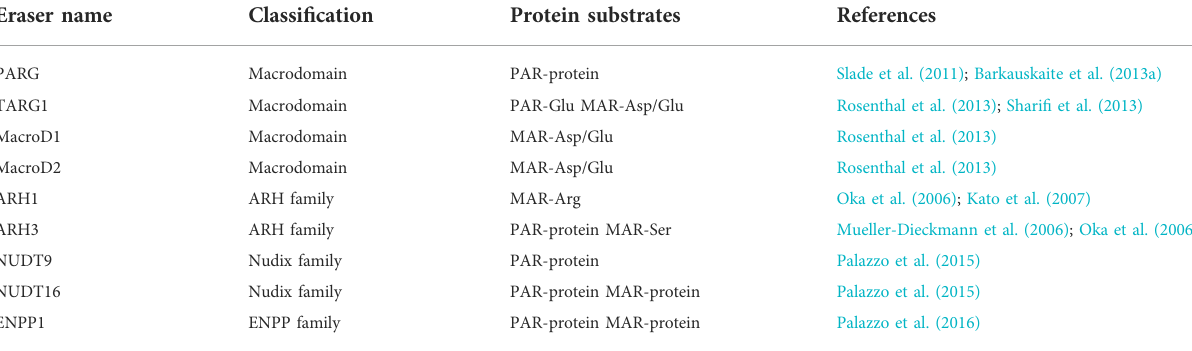
TABLE 2 Summary of ADP-ribosylation